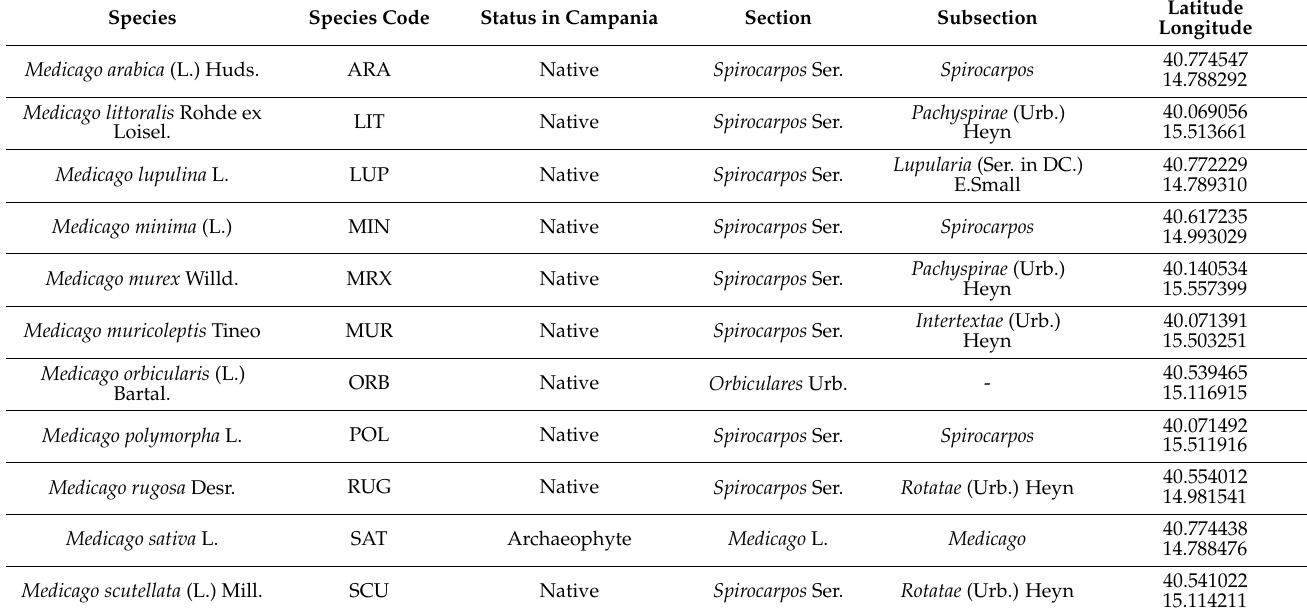
Table 1. Scientific names, sections, and subsections of the 11 Medicago species collected in Campania, with geographical coordinates of the collection sites (WGS84) [4]. The status in Campania follows the checklist of the Italian flora